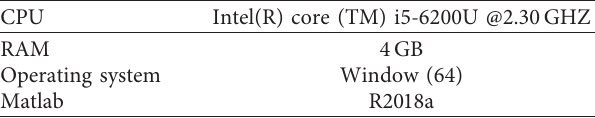
Table 2: Experimental environment. CPU